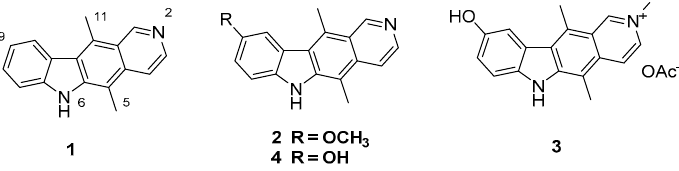
Figure 1. Structures of Ellipticine 1 and related anticancer agents.